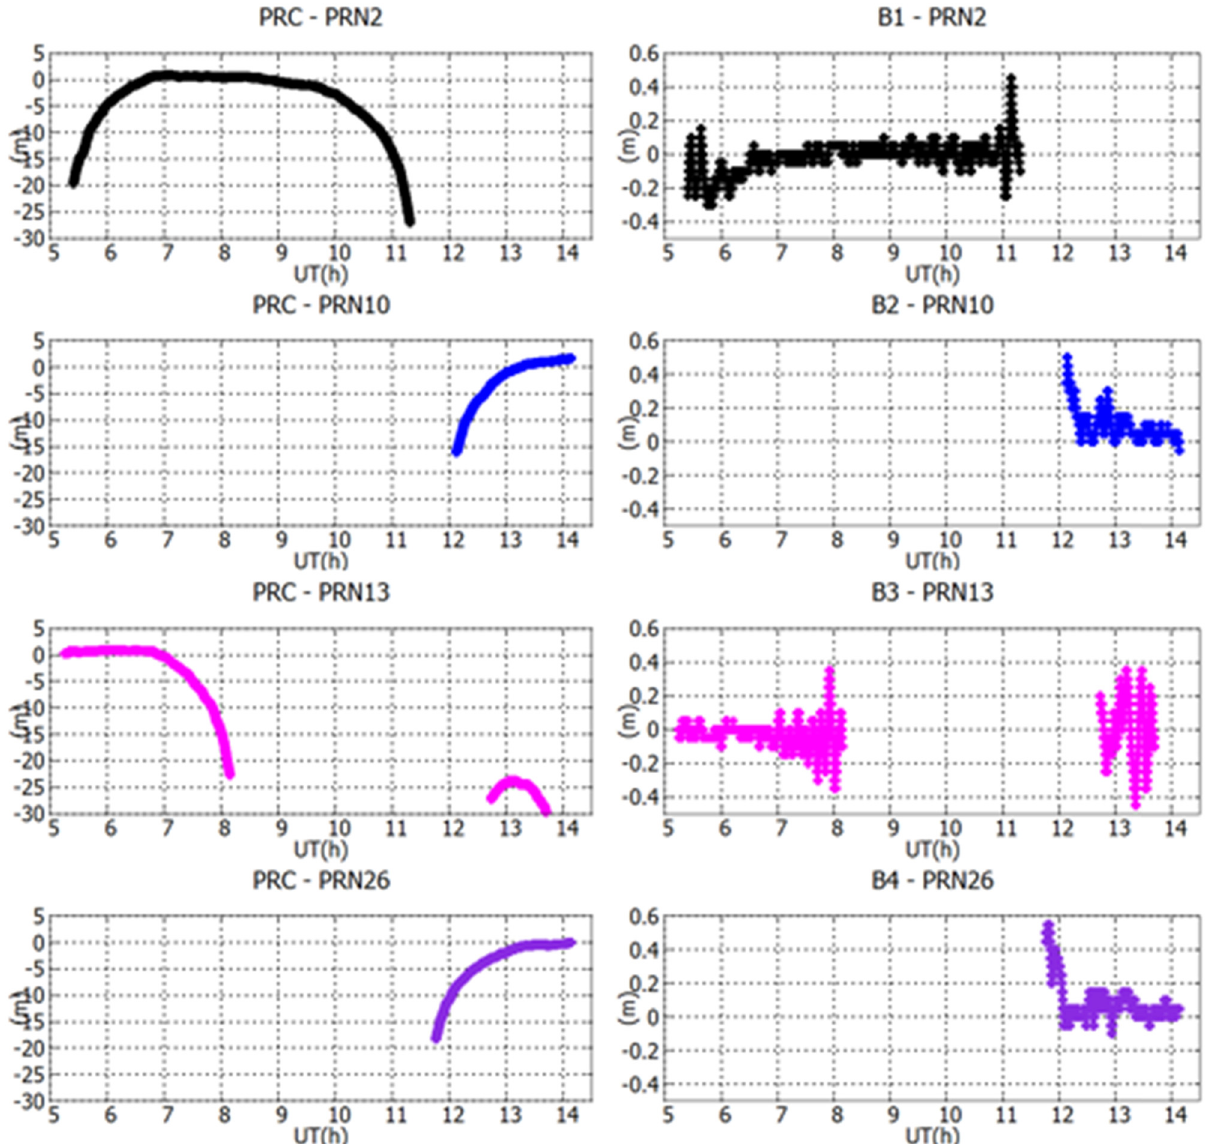
Figure 9: PRC and B - Values for PRN satellites 2, 10, 13, and